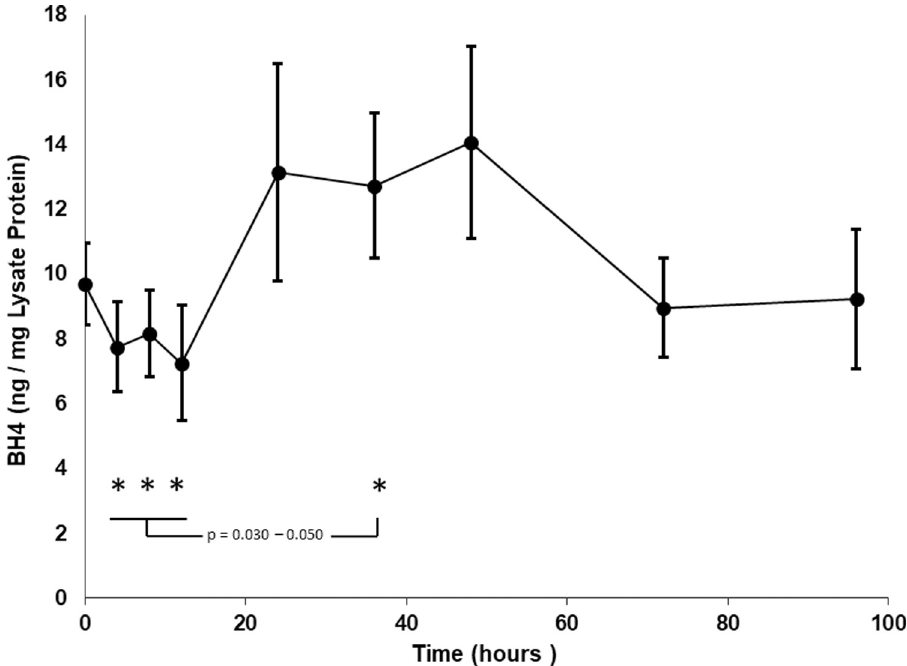
Fig 7. Tetahydrobiopterin (BH4) levels in neutrophil lysates. Free BH4 was measured in neutrophil lysates at all study timepoints by a competitive ELISA assay. Numbers represent mean ± SEM for 7 patients. No differences were between pre administration levels (time 0) and all other times. However, results for 4, 8, 12 hours compared to 36 hours (asterisks) were significantly different p = 0.030–0.050 by paired t-test.